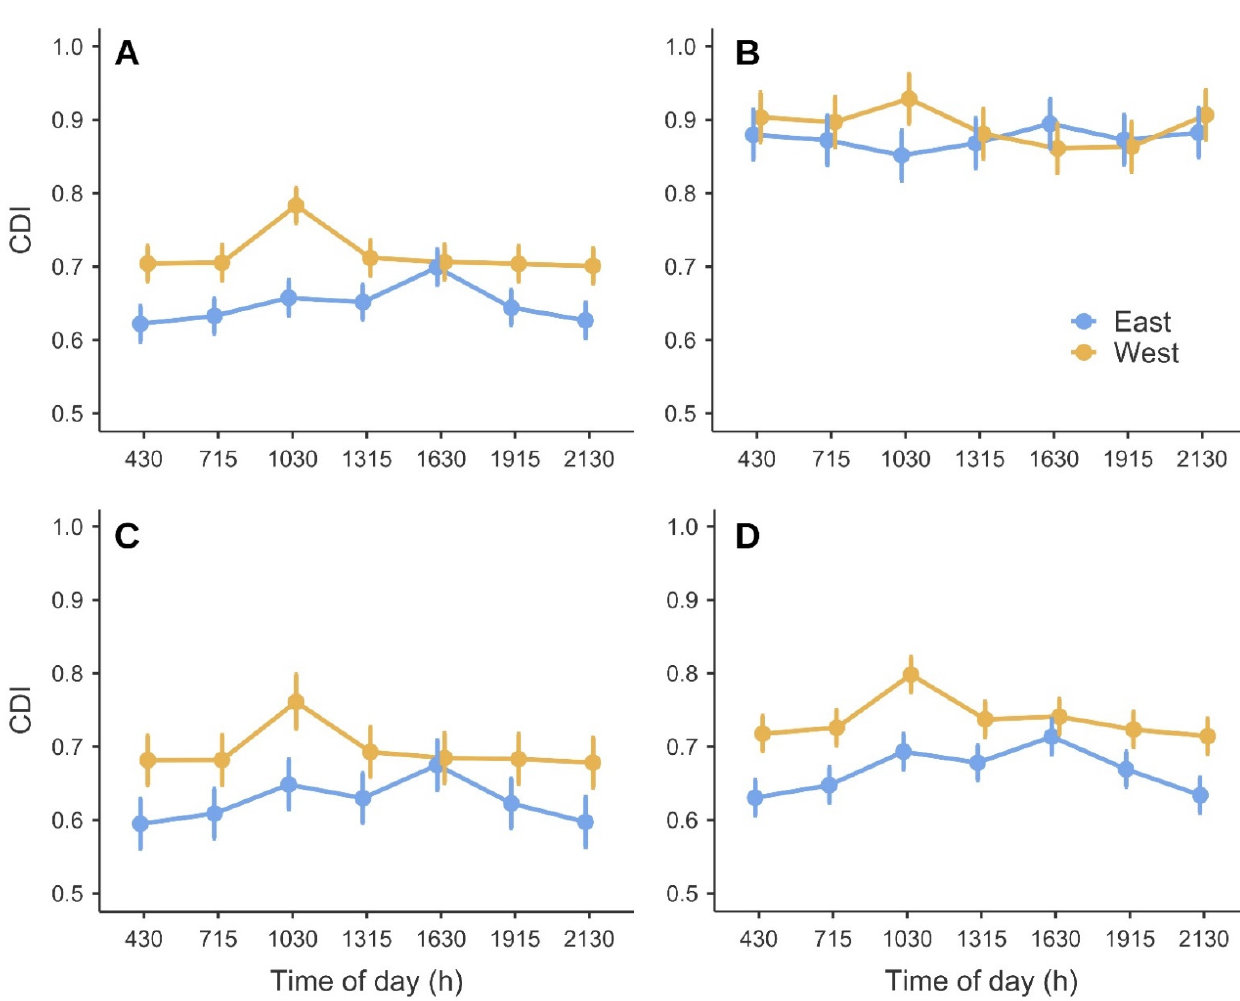
Figure 6. Daily trends of colour development index (CDI) in fruit of ( A ) ‘O’Henry’, ( B ) ‘Snow Flame 23’ and ( C ) ‘Snow Flame 25’ peaches, and ( D ) ‘August Bright’ nectarine in the east and west side of the canopies. Error bars represent 95% confidence intervals of the estimates.